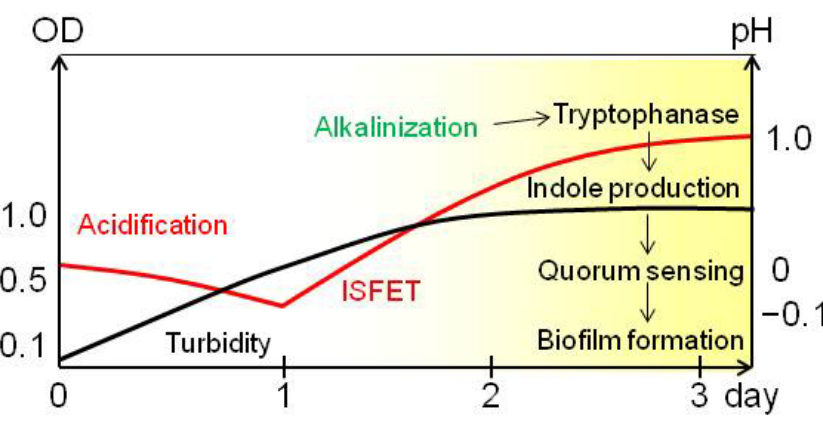
Figure 5. Schematic presentation of the mechanism of M. luteus biofilm formation. Biofilm formation was facilitated in the alkalinization phase. Changes in turbidity and pH measured using the ISFET sensor are shown with black and red lines, respectively. The yellow shadow indicates the phase of biofilm